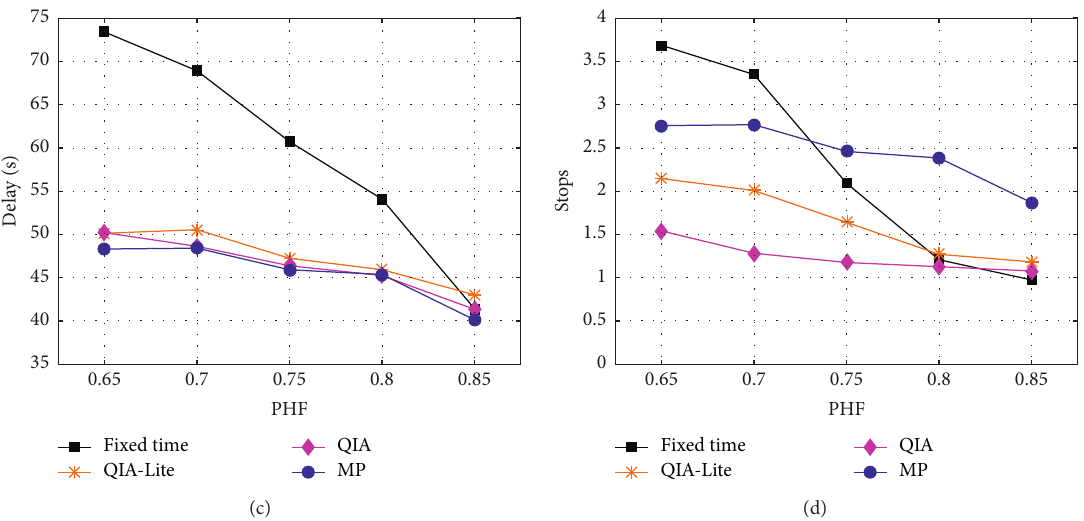
Figure 8: The comprehensive results of four methods over study period. (a) Extreme queue intensity (EQI). (b) Temporal percentage of queue spillback (TPQS). (c) Delay per vehicle. (d) Stops per vehicle. Table 3: The comprehensive results of four methods. EQI Methods